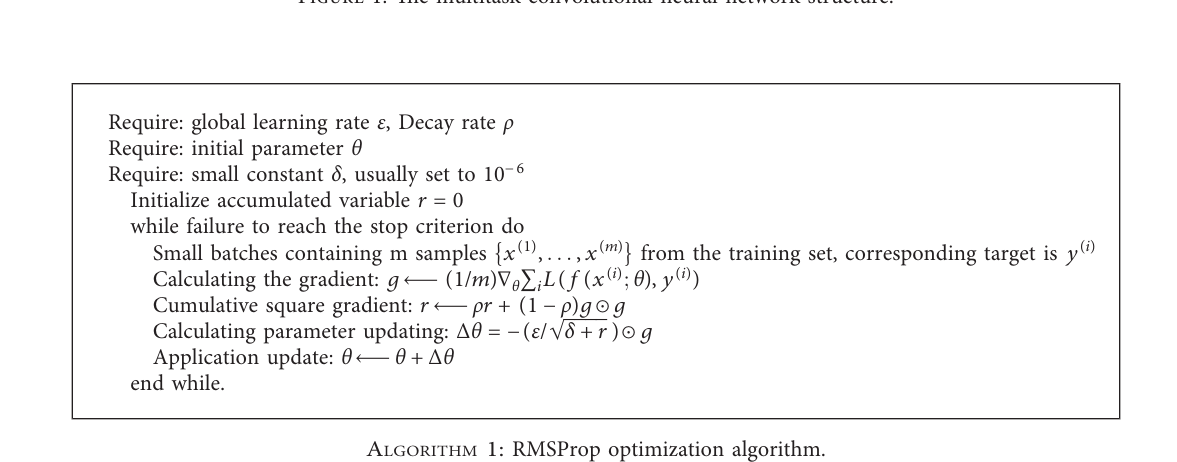
Figure 1: The multitask convolutional neural network structure.